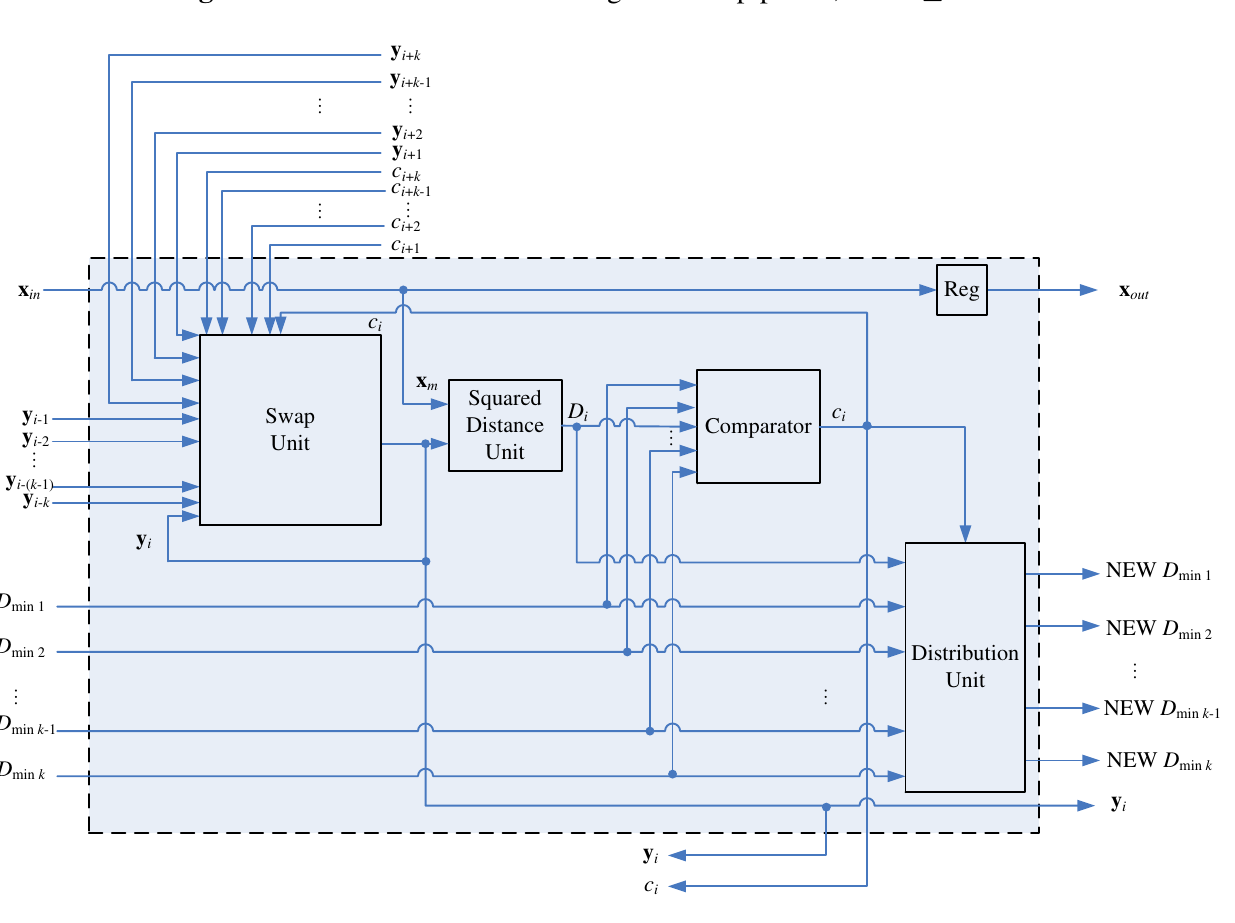
Figure 8. The architecture of the stage i of the pipeline, k < i ≤ N − k